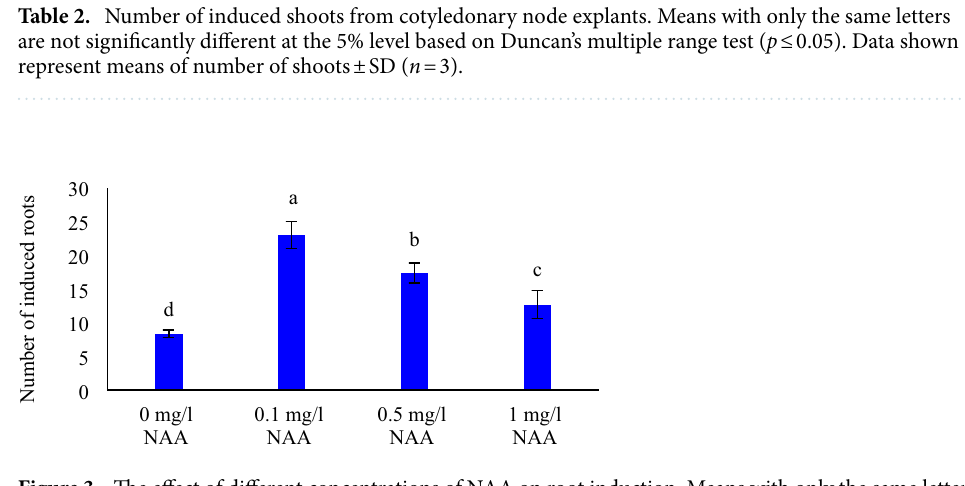
Figure 3. The effect of different concentrations of NAA on root induction. Means with only the same letters are not significantly different at the 5% level based on Duncan’s multiple range test (p ≤ 0.05). Data shown represent means of induced roots ± SD (n =